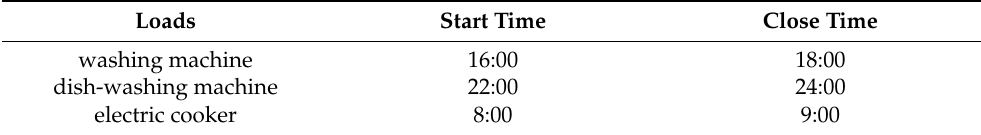
Table 5. Operation time of the shiftable and undisturbed